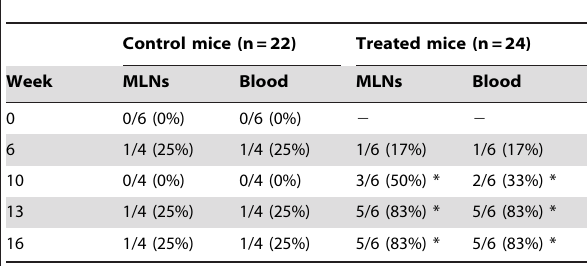
Table 3. Bacterial DNA translocation at laparotomies in control and treated